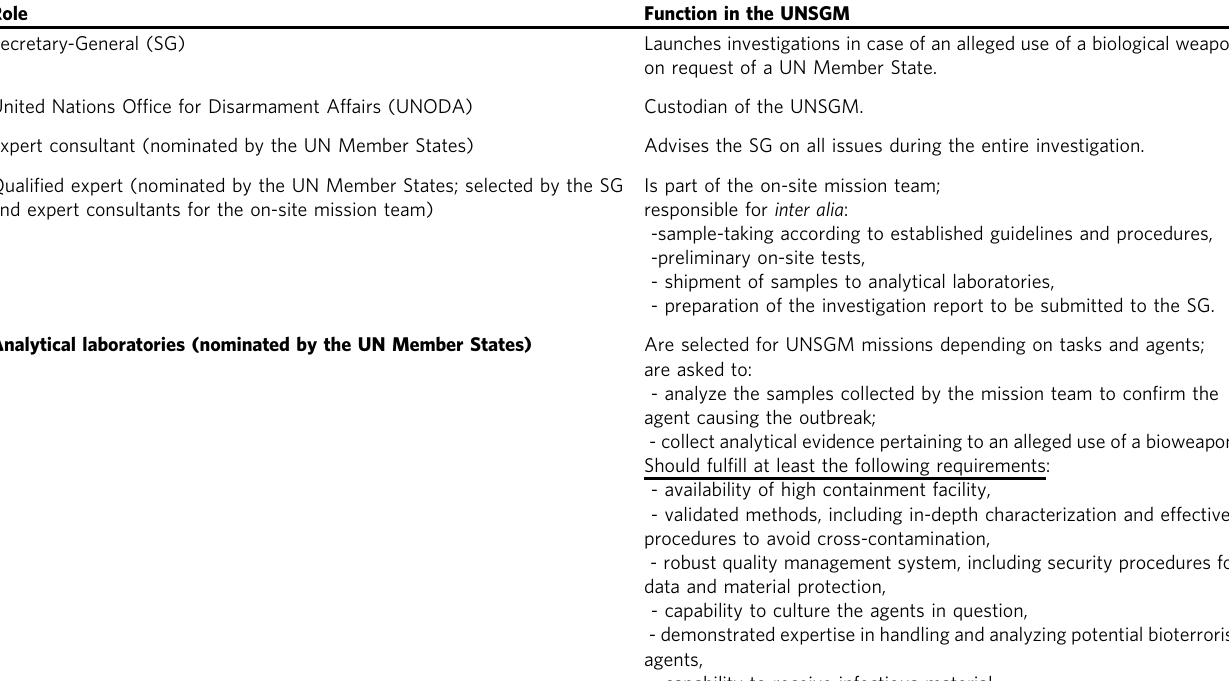
Table 1 Functions in the United Nations Secretary-General ’ s Mechanism (UNSGM) as described in the ‘ Guidelines and Procedures for the Timely and Ef fi cient Investigation of Reports of the Possible Use of Chemical and Bacteriological (Biological) or Toxin Weapons ’ 14